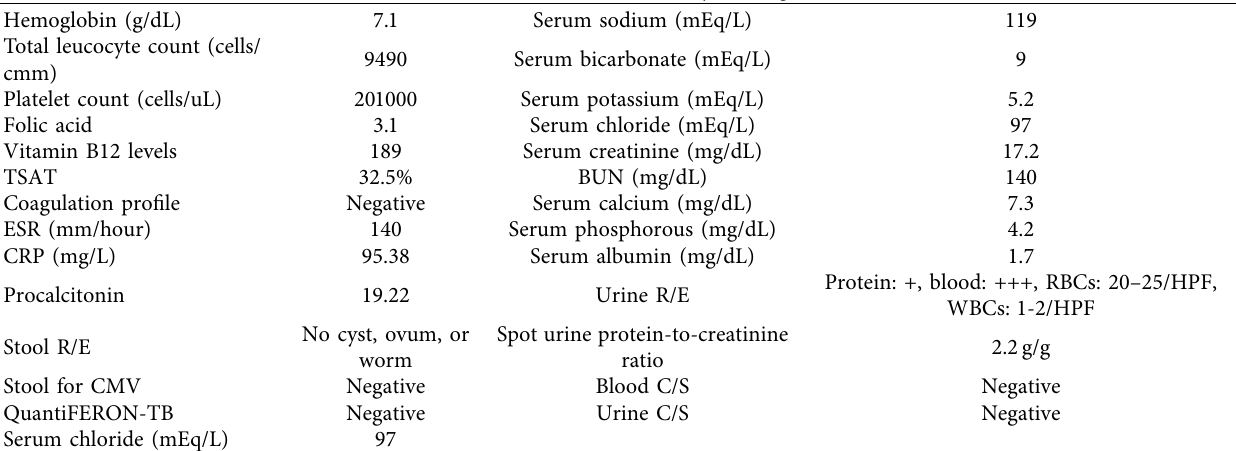
Table 1: Postadmission laboratory